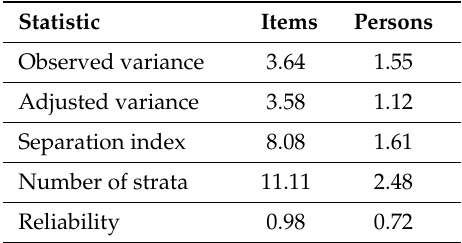
Table 4. Analysis of differential item functioning for the PIPK questionnaire comparing RNs versus ANs.